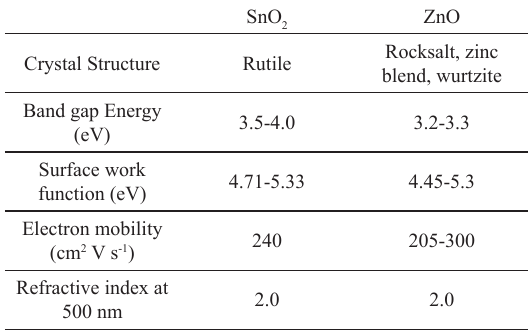
Table 1. Optical and electrical properties of SnO